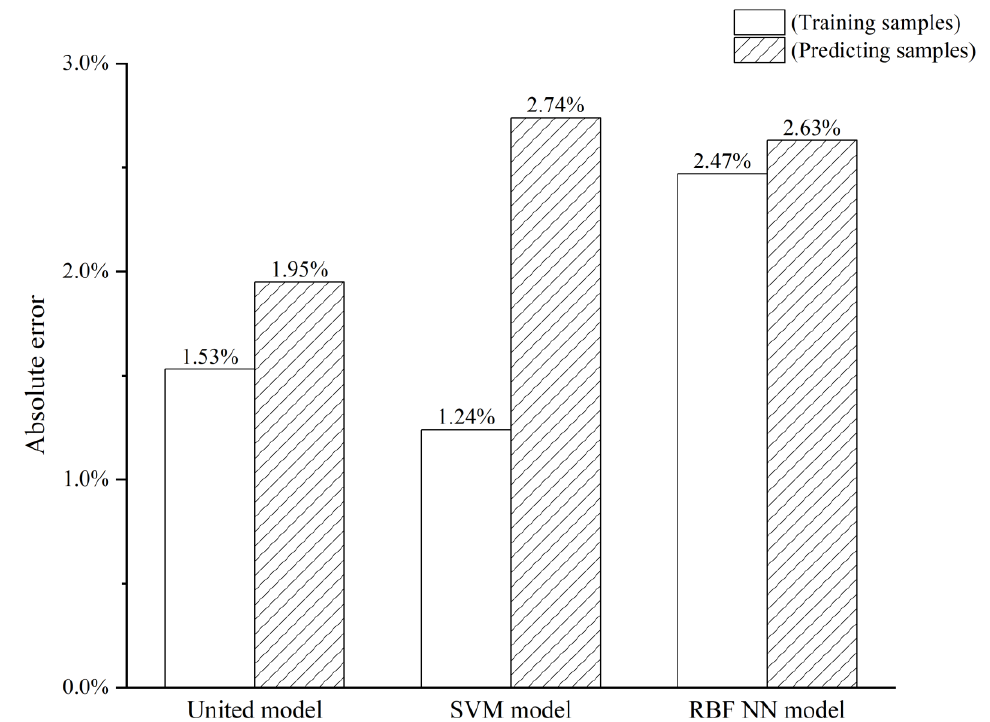
Figure 4. Comparison of SVM, RBF NN, and hybrid model for modeling and predicting.